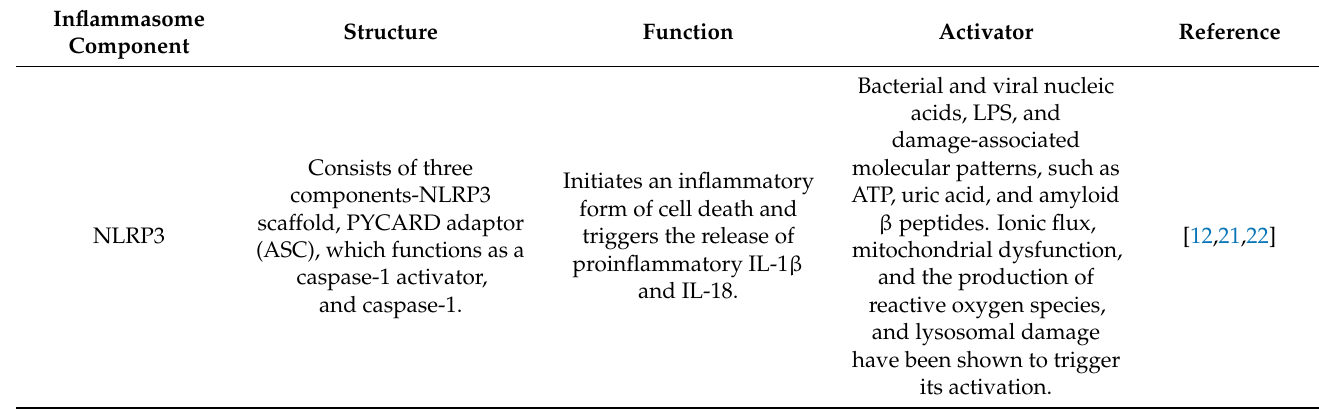
Table 1. Proposed inflammasome components and molecular mechanisms related to their function and activation. The table gives the components most consistently reported in kidney disease to